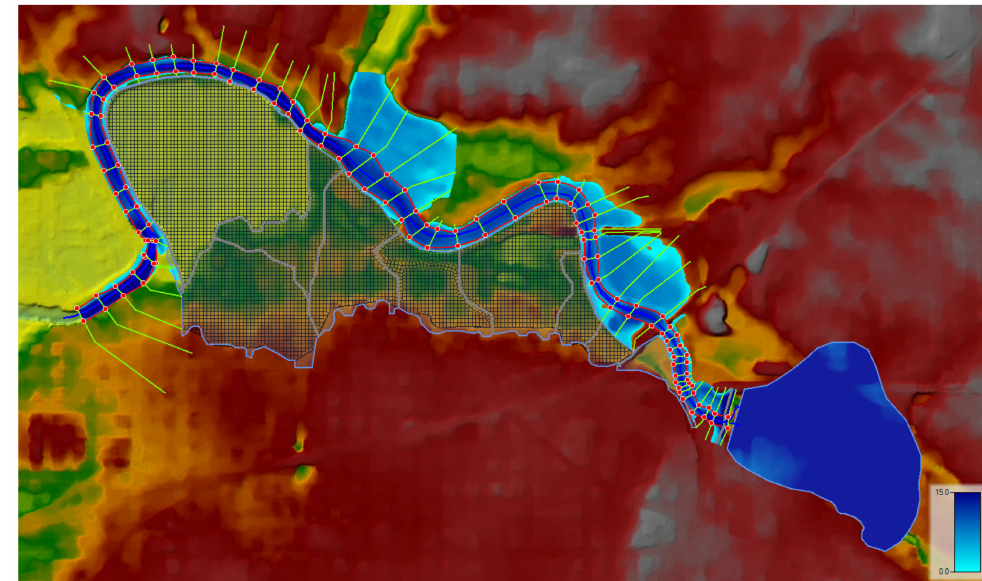
Figure 8. Inundation area (water depths (ft) shown in blue) at the City of Muncie with the optimal O/S model